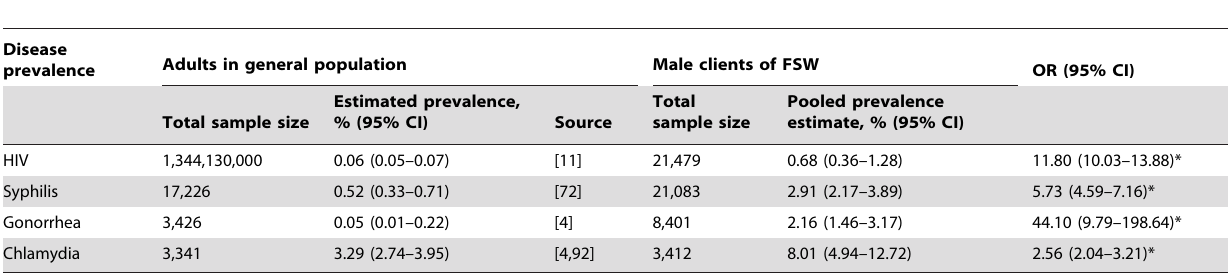
Table 4. Odds ratios and 95% confidence intervals for the prevalence of STIs among male clients of FSW compared to the general population in